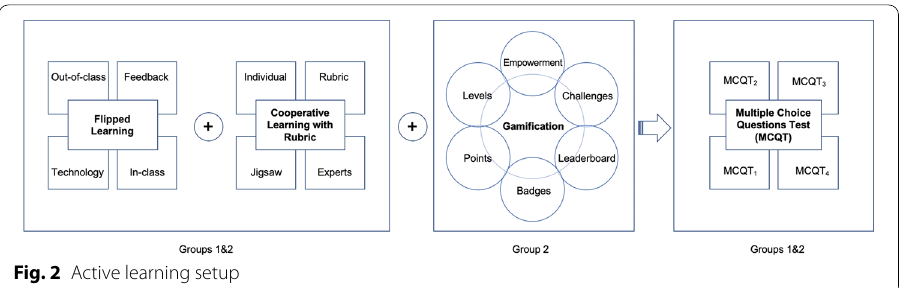
Fig. 2 Active learning